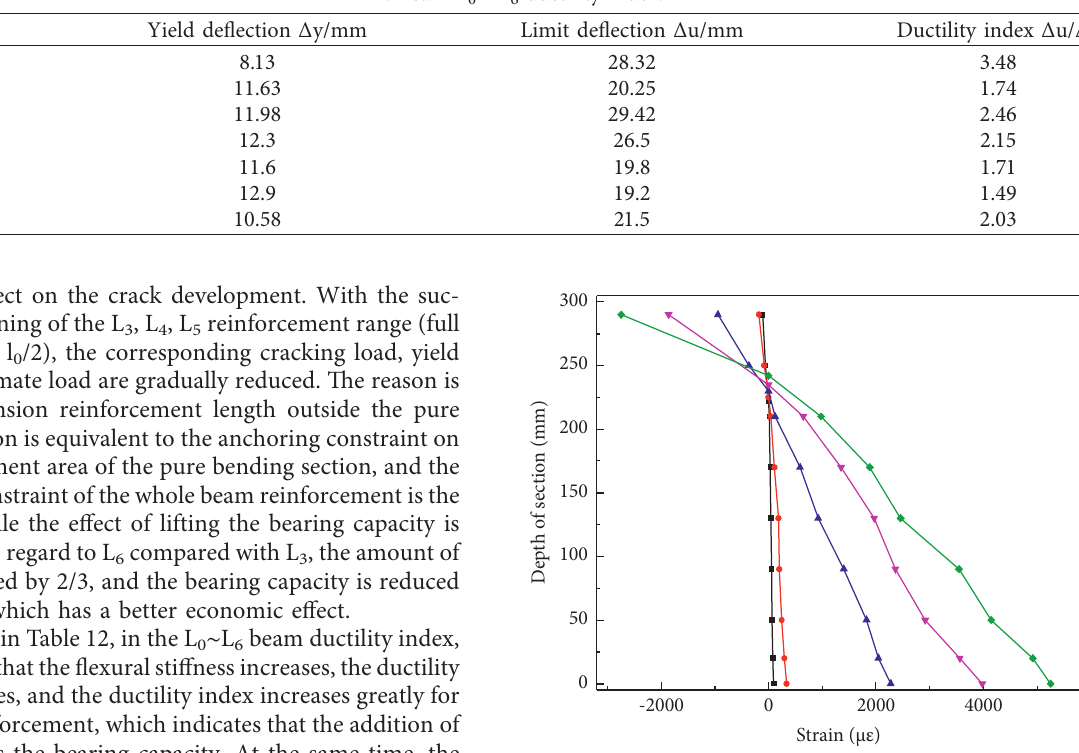
Table 12: Beam L